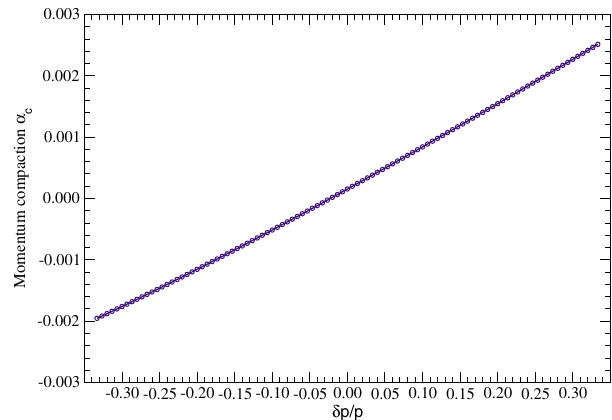
FIG. 12. (Color) Dependence of momentum compaction (cid:24) on momentum